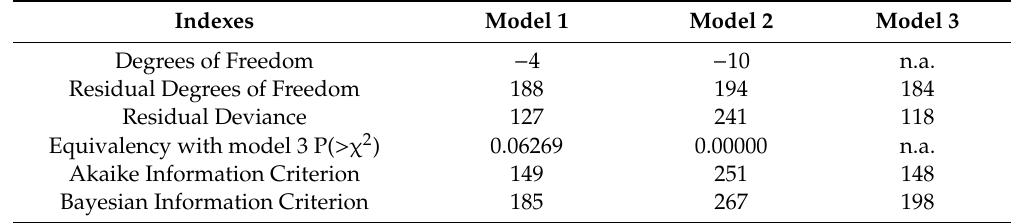
Table 4. Model comparison based on the likelihood ratio and on Akaike and Bayesian information criteria. Indexes Model 1 Model 2 Model 3 Degrees of Freedom − 4 − 10 n.a. Residual Degrees of Freedom 188 194 184 Residual Deviance 127 241 118 Equivalency with model 3 P( > χ 2 ) 0.06269 0.00000 n.a. Akaike Information Criterion 149 251 148 185